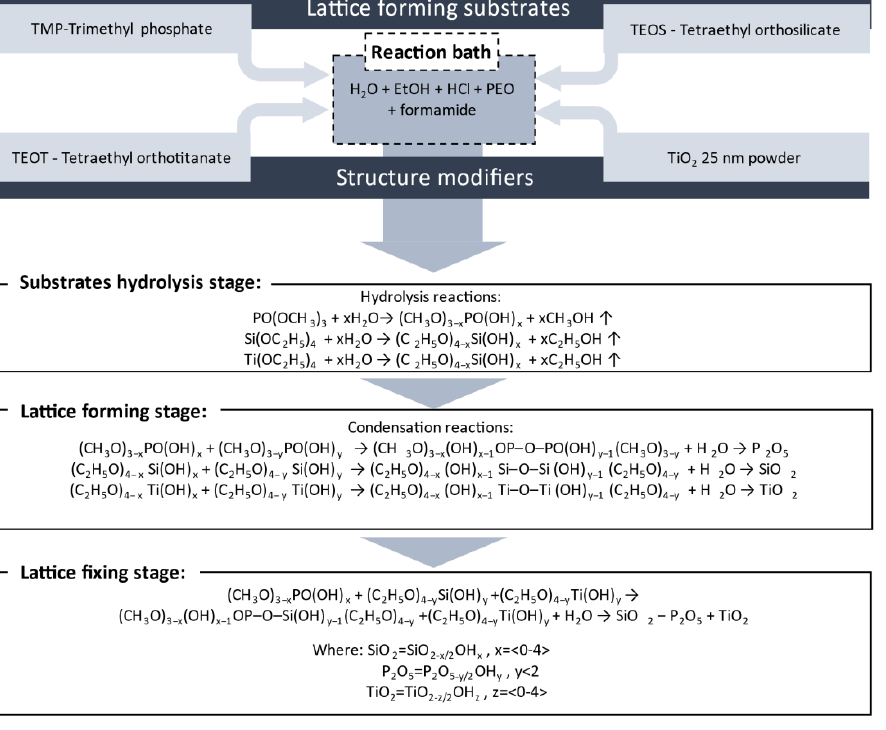
Figure 1. Schematic block diagram of the glass synthesis processes.